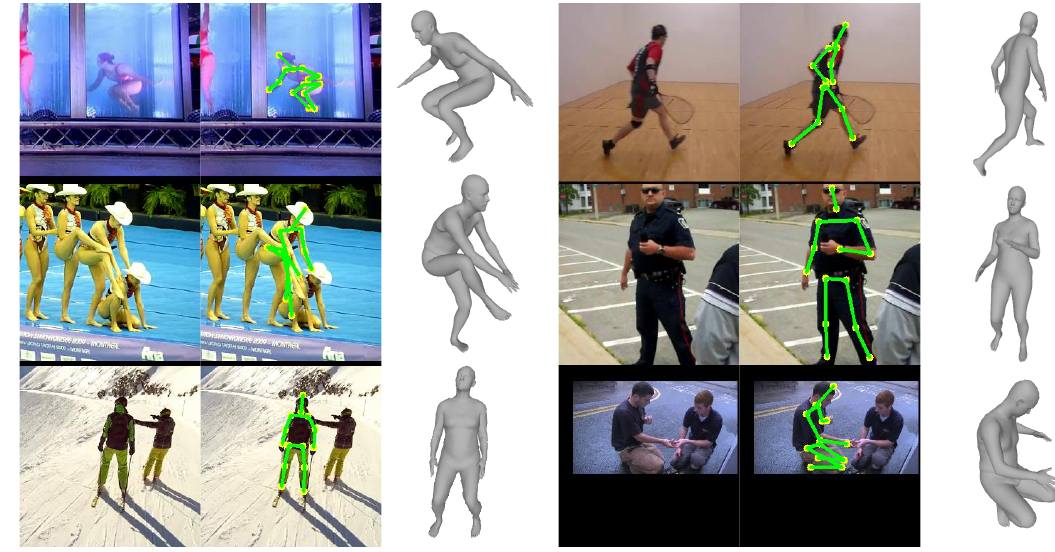
Figure 9. Qualitative results on the MPII